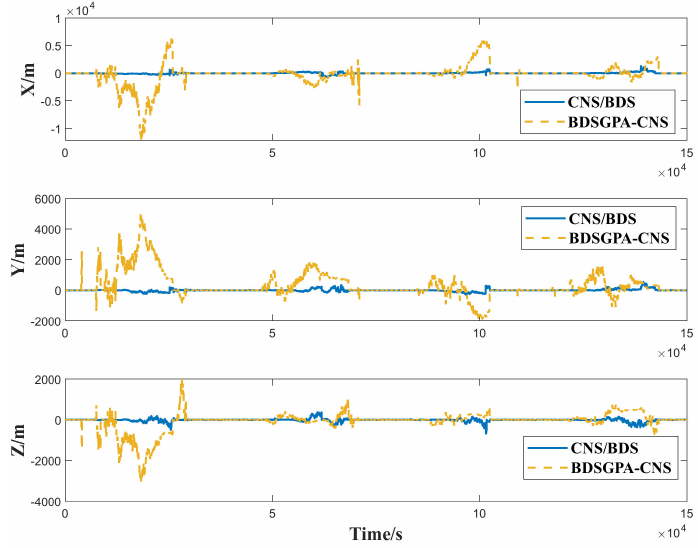
Figure 10. Position error in three